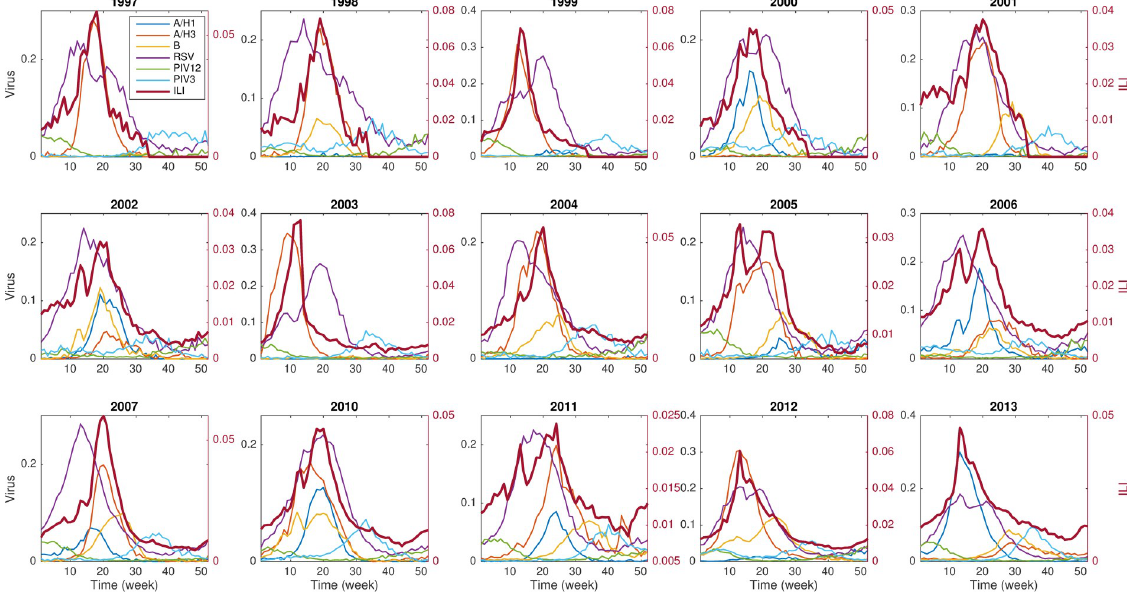
Fig 1. National ILI rates and six contributing viral signals in different seasons. The viral signal shown here is the positivity rate of each pathogen. ILI is attributed to a range of viruses with variable seasonal phasing. ILI peaks are largely driven by the circulating influenza strains.